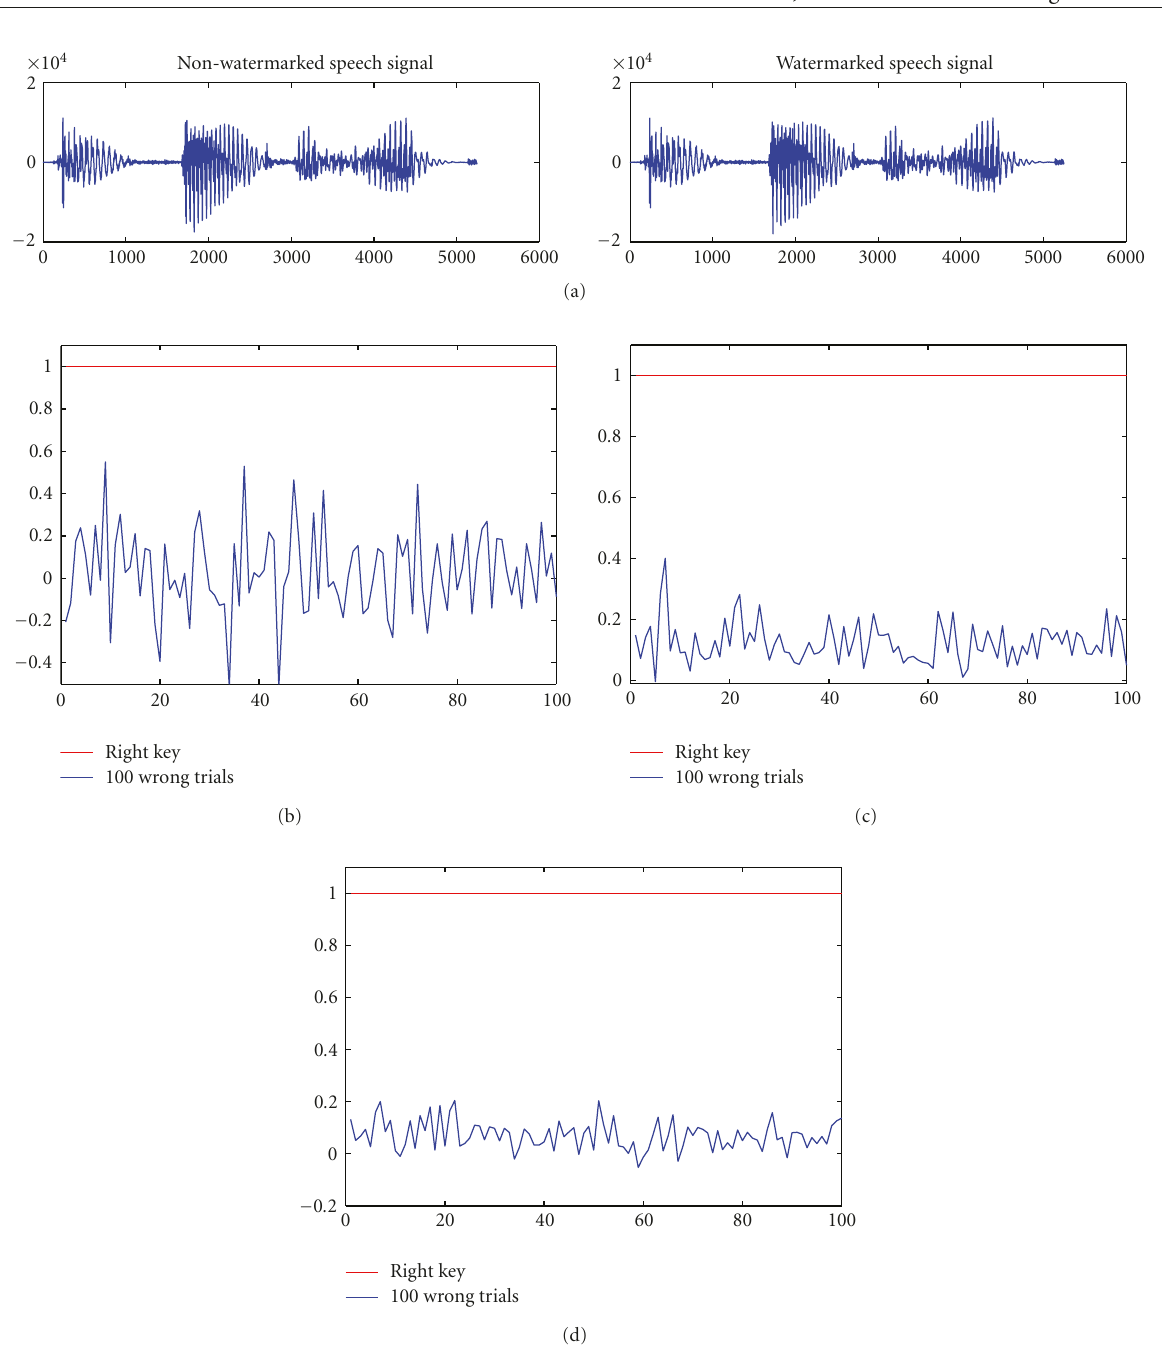
Figure 3: (a) Original and watermarked signals, (b) detection results for STFT coe ffi cients, (c) detection results for SM coe ffi cients and L = 10, (d) detection results for SM coe ffi cients and L = 32 (SNR = 24